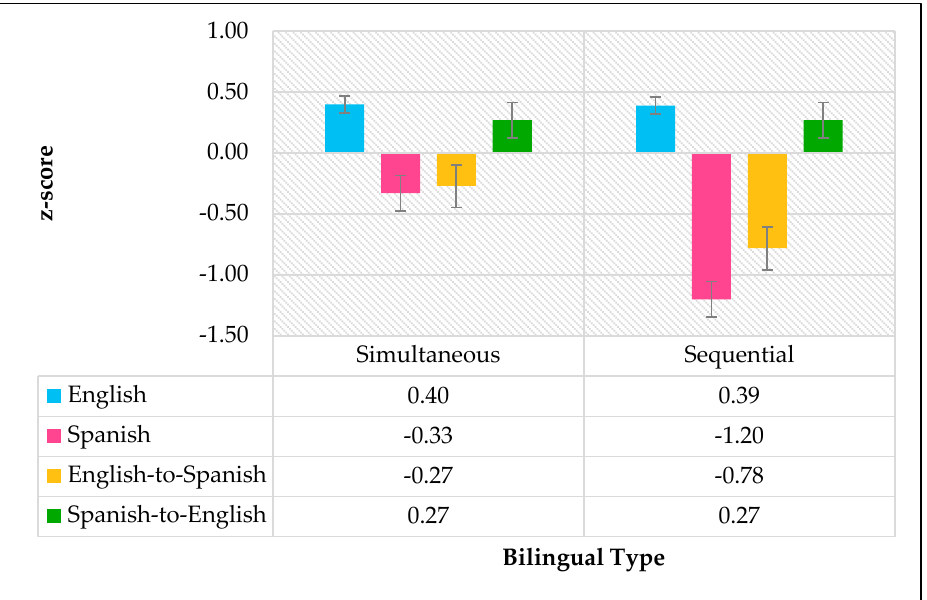
Figure 2. Average z-score by language(s) and bilingual type.